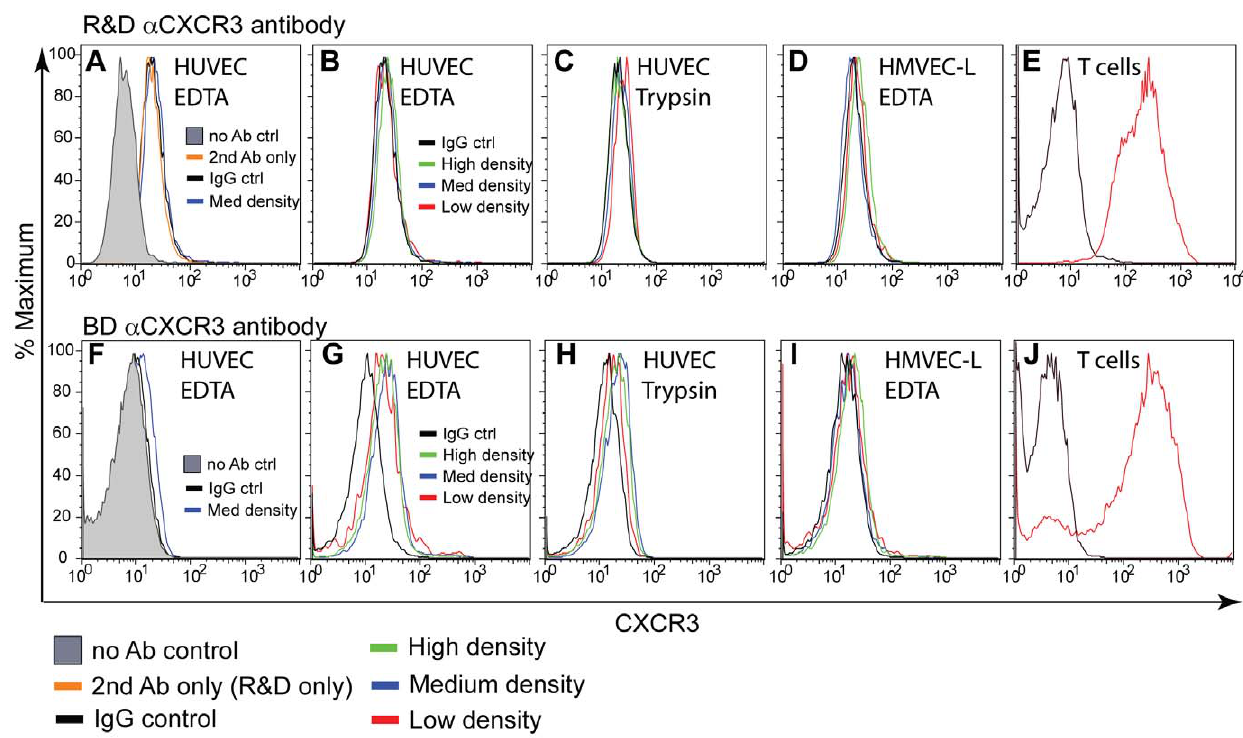
Figure 5. HUVEC and HMVEC-L have no detectable surface CXCR3 expression. CXCR3 surface levels were assessed by flow cytometry using anti-hCXCR3 monoclonal antibodies from R&D (A–E), or BD Bioscience (F–J), for HUVECS (A–C, F–H), HMVEC-L (D and I) and human peripheral blood T cells cultured in IL-2 (E and J). Endothelial cells were harvested at different densities to determine cell cycle dependency of CXCR3 expression (B–C, G–H), and were harvested either with EDTA (A, B, D, F, G, I) or trypsin (C and